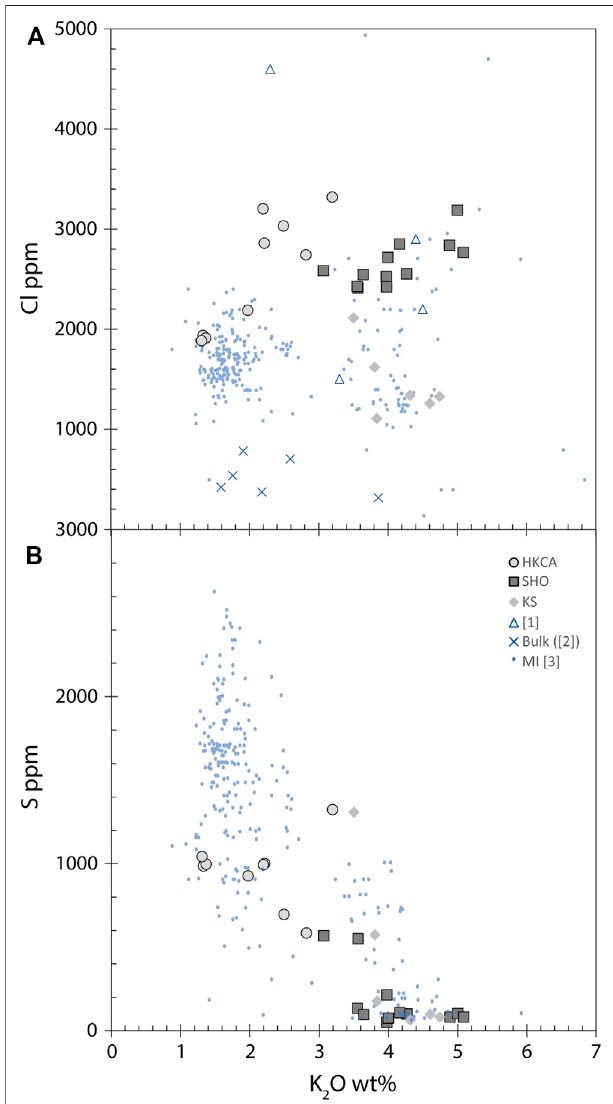
FIGURE4| Silicacontent plotted against (A) potassium content and (B) K 2 O+Na 2 O(wt%) forST2meltinclusions.Manzini etal.(2017) datafromST2 are also plotted for comparison (empty triangles, [1]), as well as the Stromboli bulk data for which δ 37 Cl have been calculated ([2]: Liotta et al., 2017; crosses). The shaded fi eld represents whole rocks (georock database) and blue dots ([3]) represent melt inclusions from other Stromboli samples (e.g., Métrich et al., 2001; Bertagnini et al., 2003; Métrich et al., 2010; Rose-Koga et al., 2012; Schiavi et al., 2012). Major elements of melt inclusions entrapped in olivine have been corrected for post-entrapment crystallization.